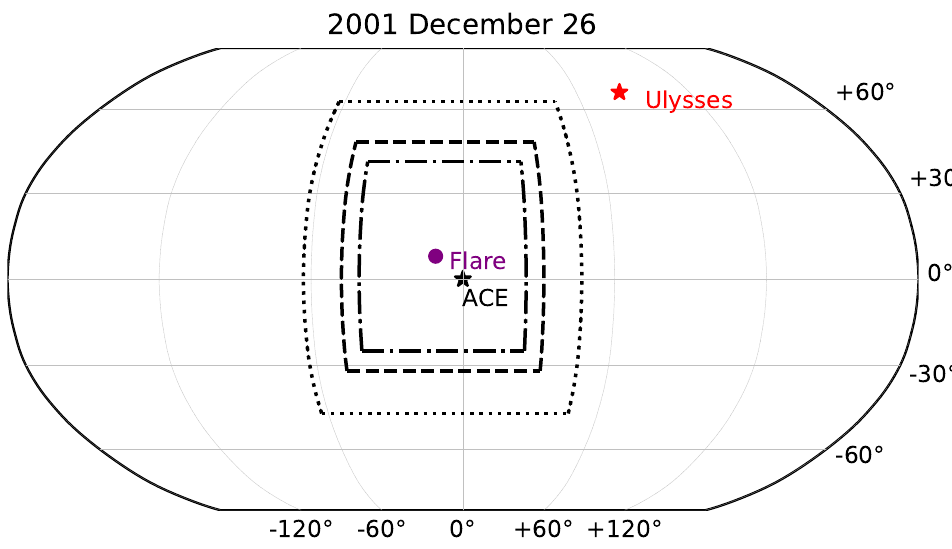
Figure 4. Illustration of the footpoints of ACE and Ulysses on the solar surface on 26 December 2001 relative to the flare (similar as in Figure